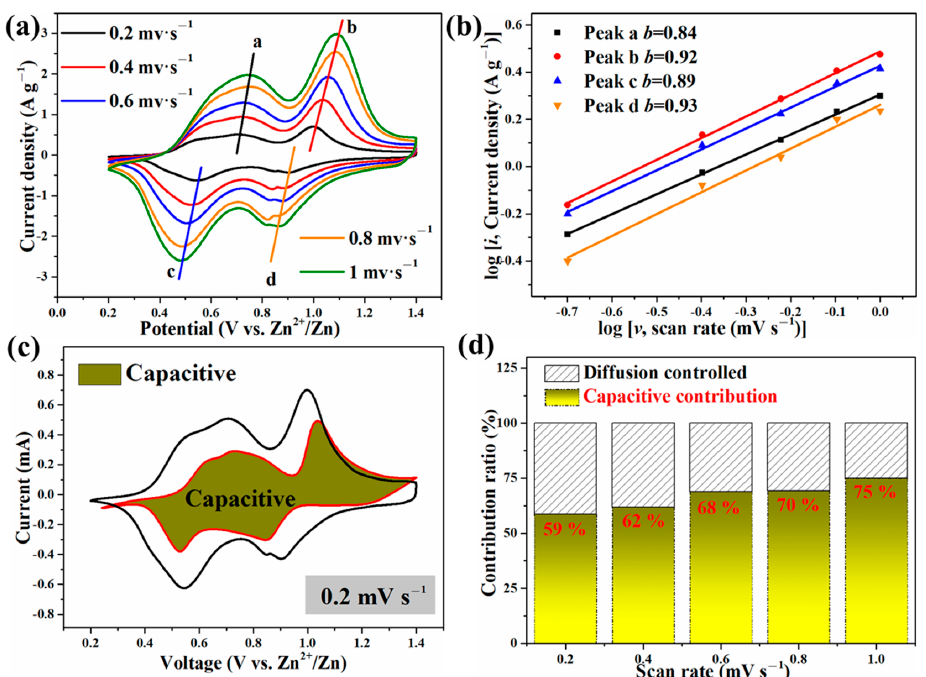
Figure 7. The electrochemical kinetics of Zn//ZnVOH/rGO battery: ( a ) CV curves at 0.2~1 mV · s − 1 , ( b ) The relationship between log (sweep rate) and log (peak current); ( c ) A typical CV curve with capacitive contribution; ( d ) capacitive contributions at current